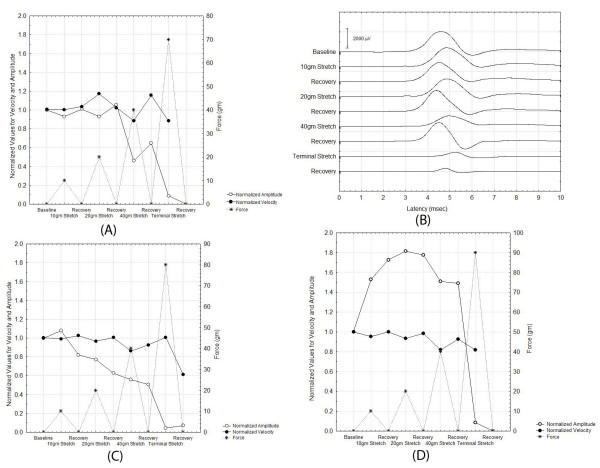
Illustration of the differences in the responses of various nerves to stretch and the typical CMAP waveforms recorded.